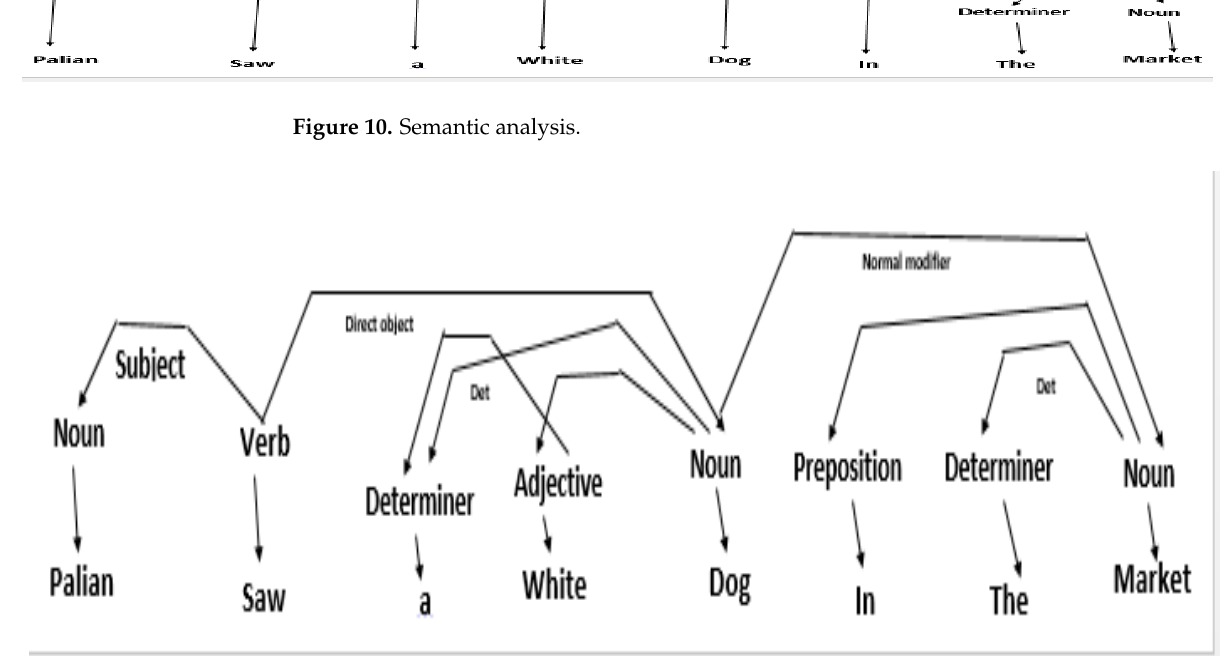
Figure 11. Text extraction and target customer base on word choice.